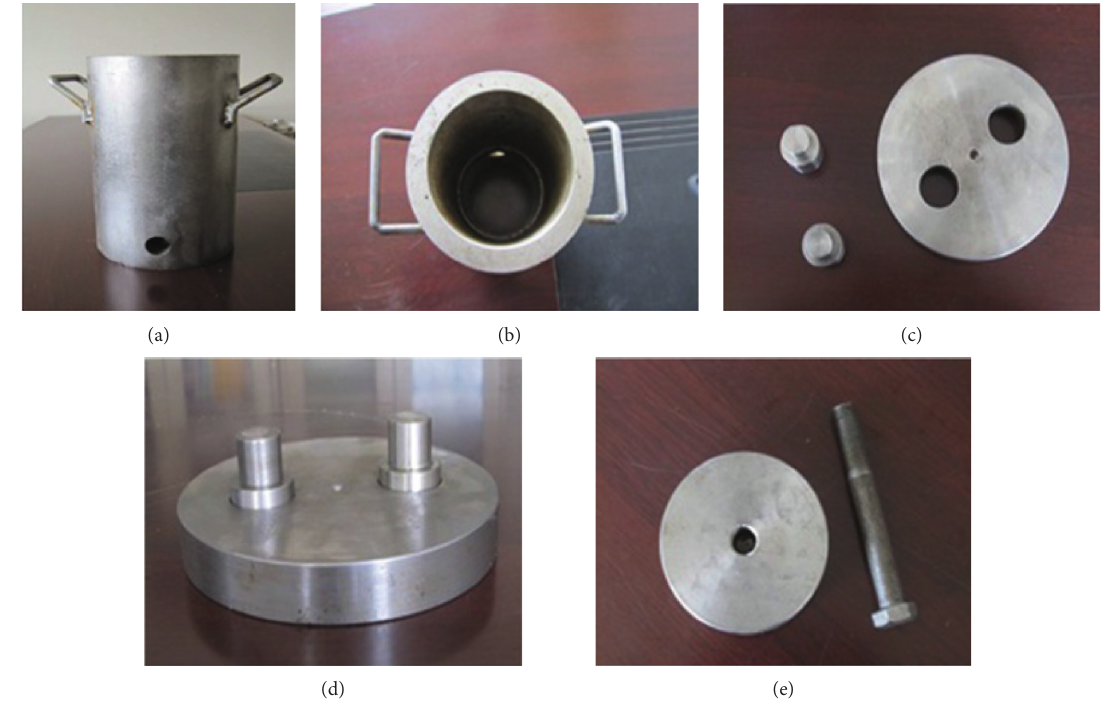
Figure 3: The container for granular material: (a, b) the fixture; (c, d) lower bearing plate and pins; (e) upper bearing plate. Table 1: Experiment groups. Experiment